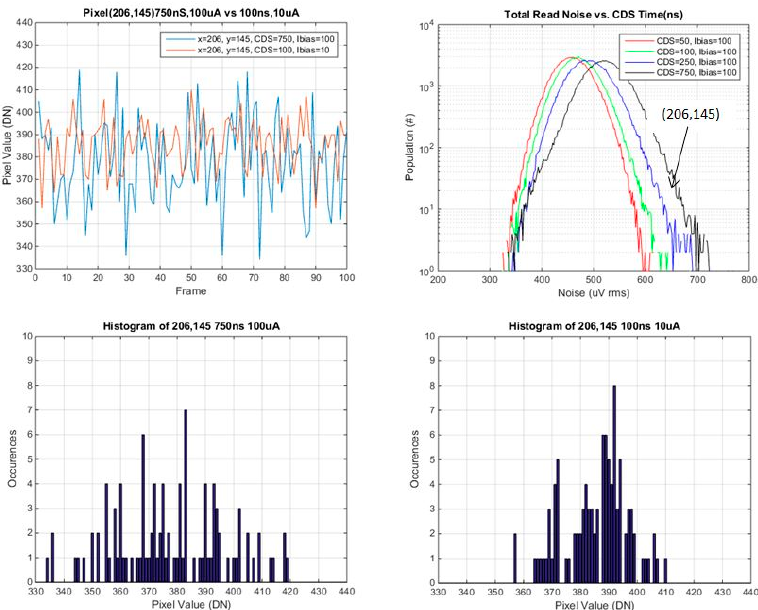
Figure 15. Pixel value vs. frame, and histogram of pixel values for pixel 206,145 (from the shoulder of the noise histogram).